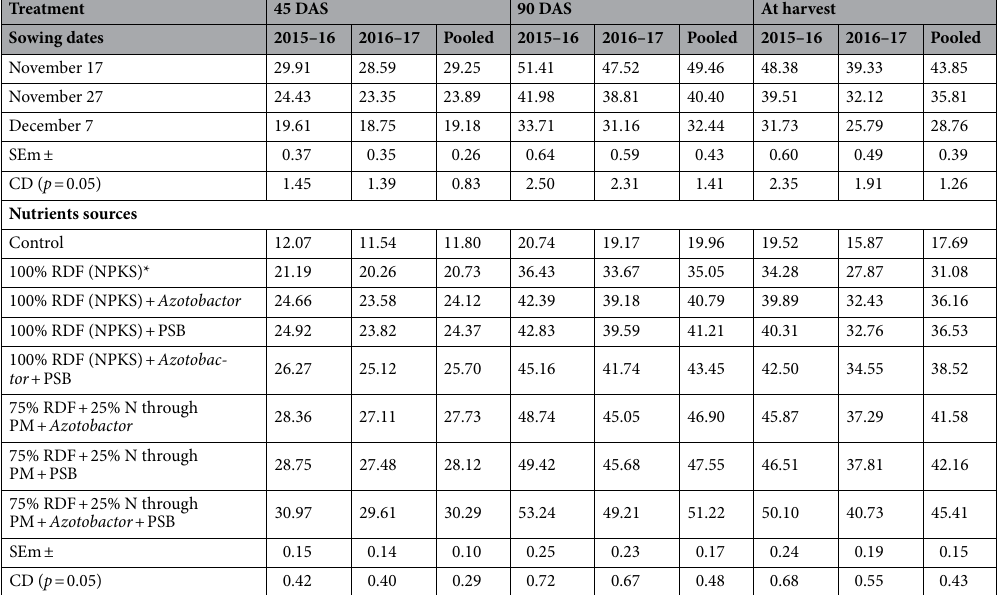
Table 1. Effect of sowing dates and nutrient sources on bacterial population (× 10 7 CFU g −1 soil) of Indian mustard. RDF, Recommended dose of fertilizers; NPKS, Nitrogen, Phosphorus, Potassium and Sulphur; PSB, Phosphorus solubilizing bacteria; PM, Pressmud. *RDF@100–50-50–40 NPKS kg ha